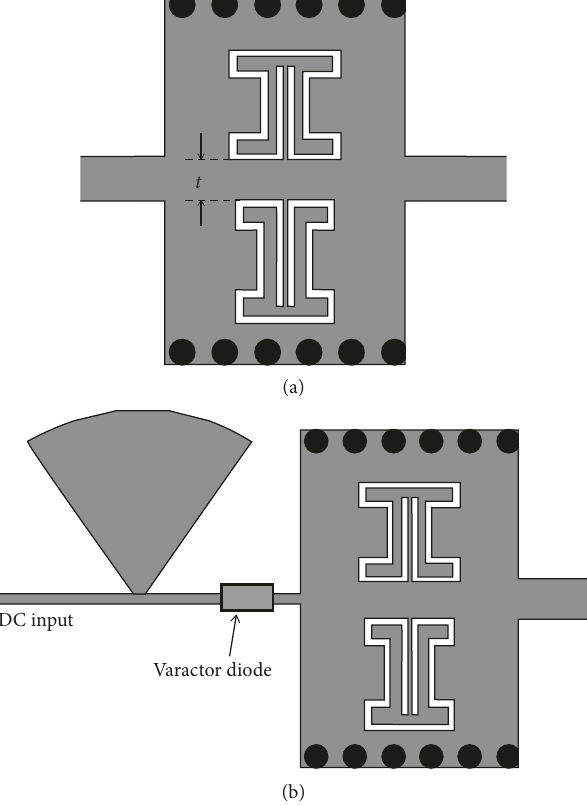
Figure 6: Configuration of the proposed resonators using pro- posed base layout: (a) first resonator [9] and (b) second